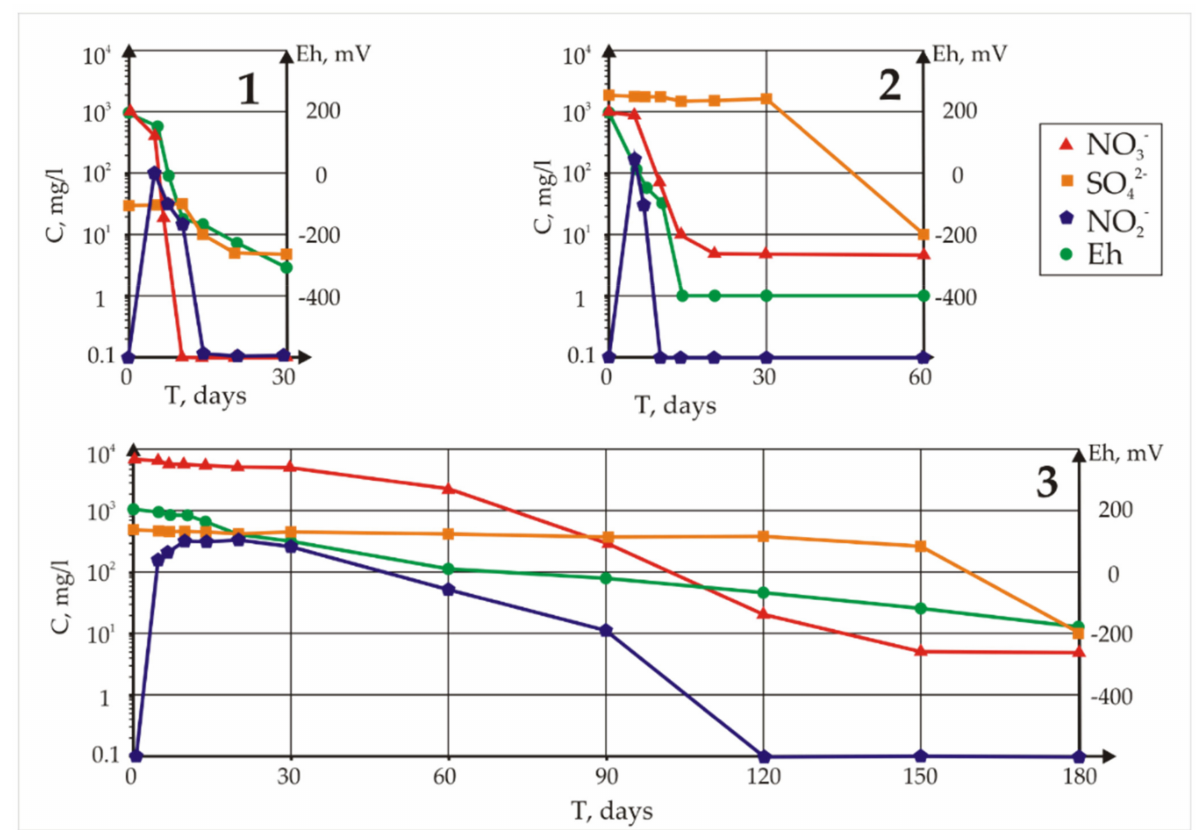
Figure 3. Results of laboratory modelling of nitrogen and sulphur reduction in the presence of whey. The pH remained at